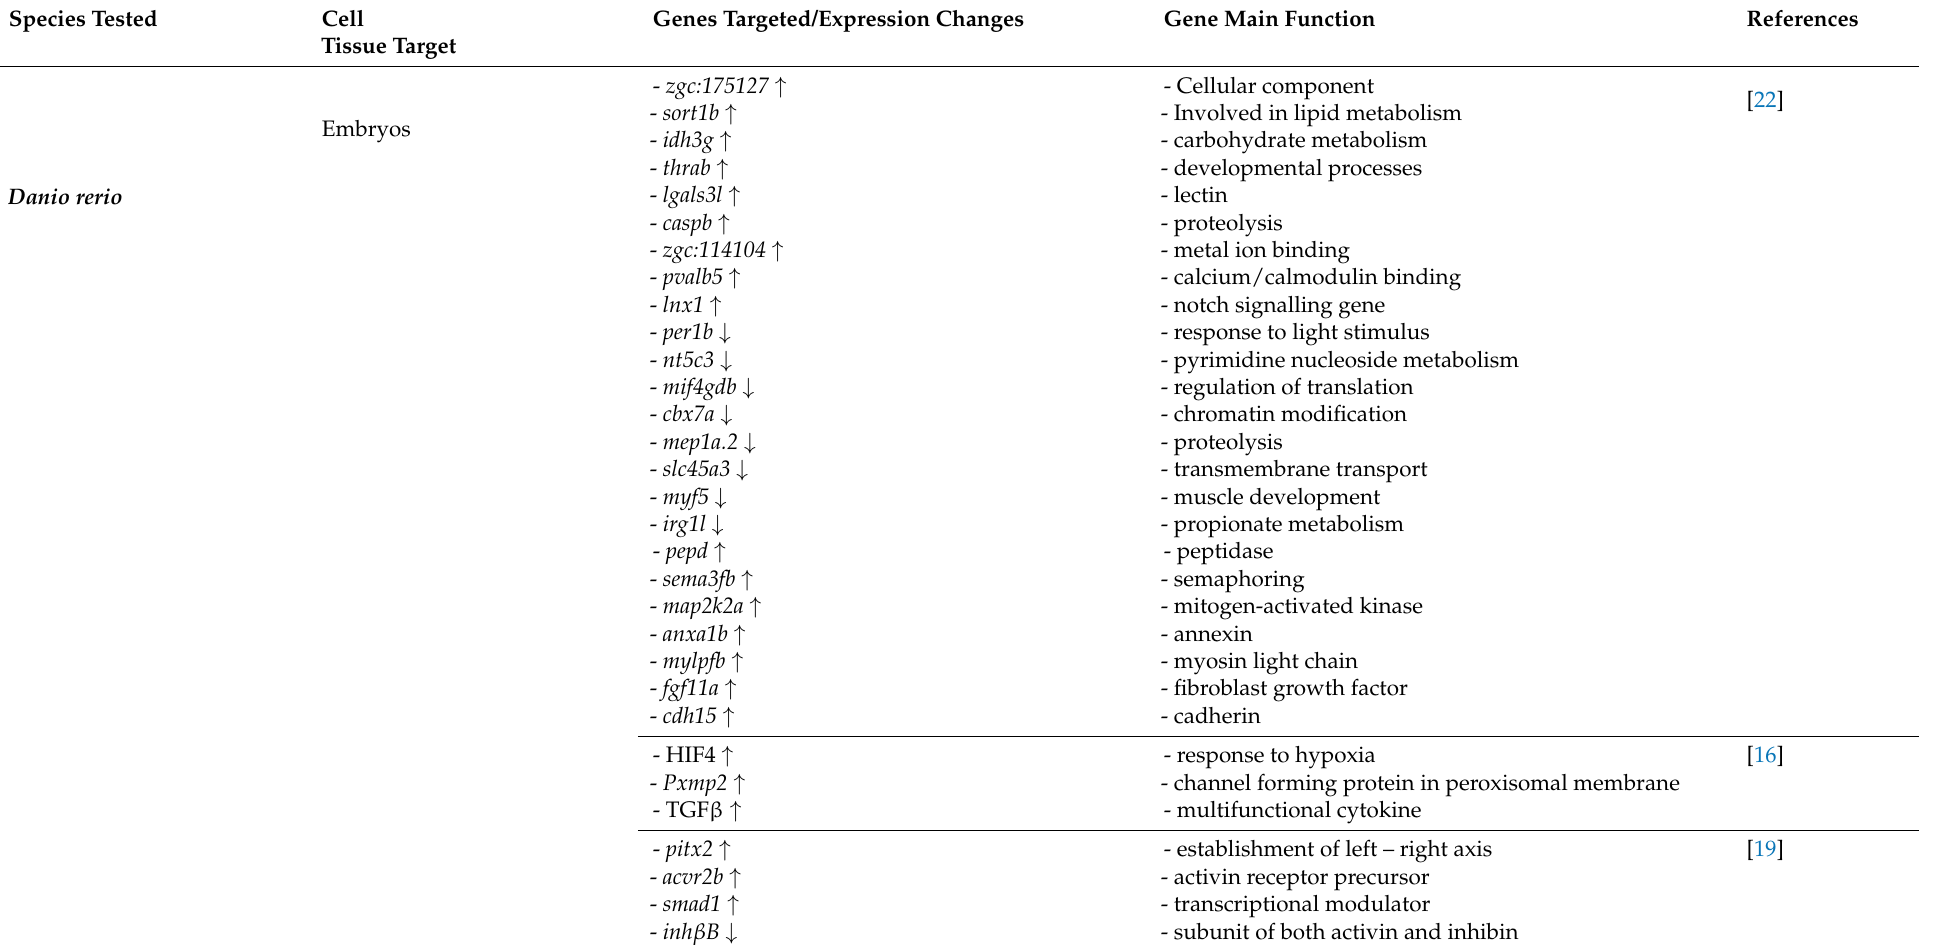
Table 1. Effects of silver nanoparticles on the genes expression of water